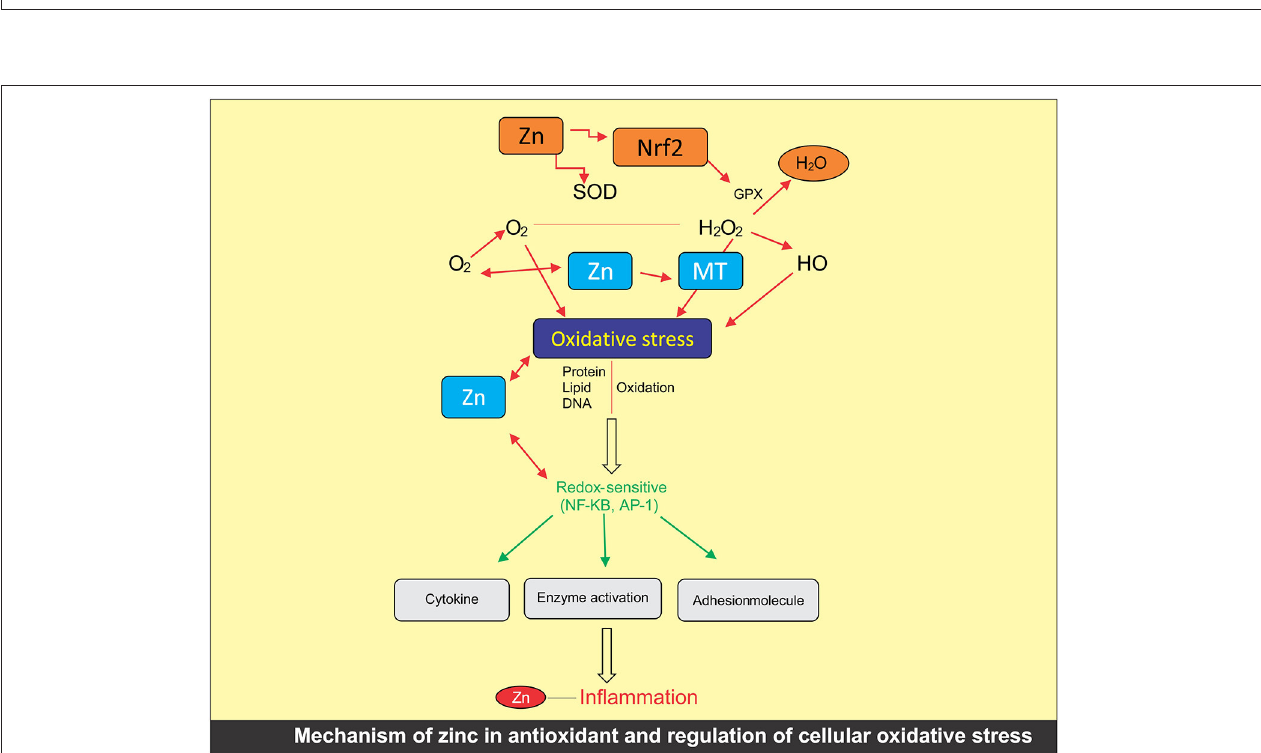
FIGURE 2 | Mechanism of zinc in antioxidant and regulation of cellular oxidative stress.